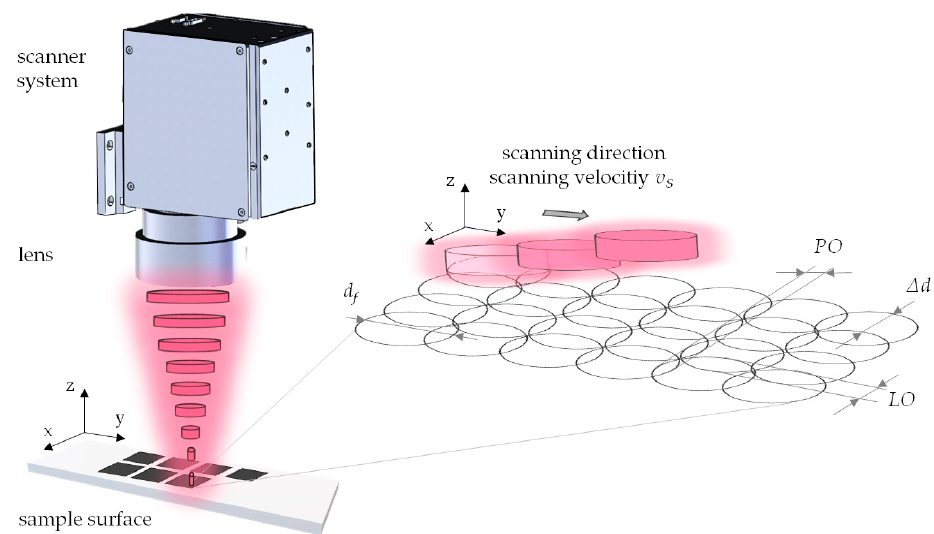
Figure 1. Schematic illustration of the laser surface structuring using a line-wise scanning strategy leading to a defined laser pulse overlap ( PO ) and scanning line overlap ( LO ). Deflecting in the x and y directions of the Gaussian laser beam is evoked by the movement of galvanic mirrors within the scanning system.